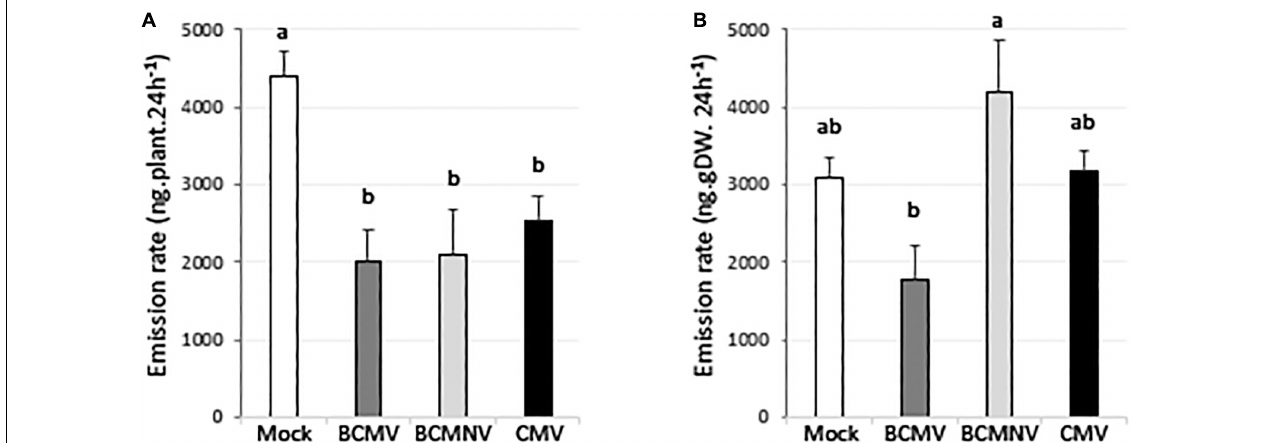
FIGURE 1 | Effects of virus infection on emission of volatile organic compounds from flowering bean plants. (A) Whole plant total emission rate (ng.24h − 1 ) of the 20 most abundant volatiles is lower in virus-infected plants compared to mock-inoculated plants. (B) VOC emission rate (ng.24h − 1 ) per gram dry weight of the combined (20 most abundant) volatiles from virus-infected plants. Mean VOC emission values for combined volatiles are presented ( n = 4 plants, or 3 plants in the case of BCMNV-infected plants, per treatment). Error bars represent standard error of the mean. Different letters are assigned to significantly different results calculated with one-way ANOVA and post hoc Tukey HSD testing ( p < 0.05). The VOC total emission rate was calculated by summing the emission of the 20 most abundant VOCs for each sample and expressing it per plant (left panel) or per ng.DW (right panel). These VOCs are listed in Supplementary Table 1 .